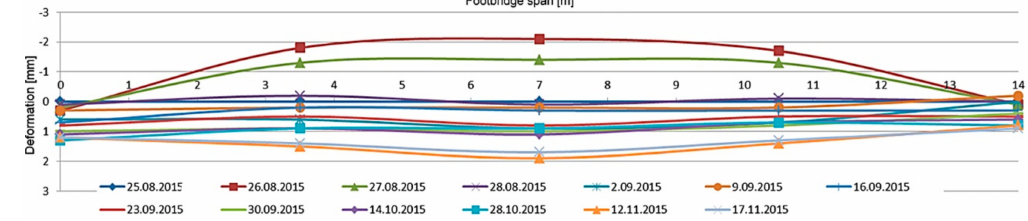
Figure 22. Normalized displacements in U4 points, footbridge with